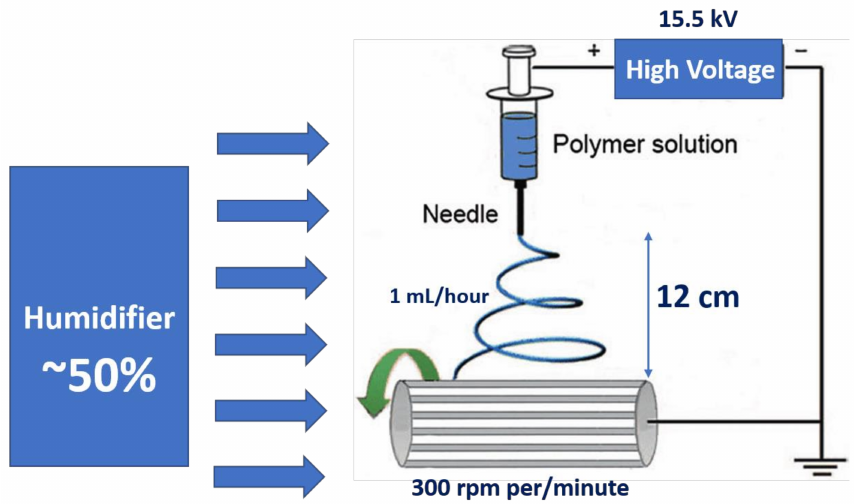
Figure 1. Schematic diagram for the preparation of TiO 2 /PVP nanofibers, SnO 2 /PVP nanofibers, and pure composite TiO 2 -SnO 2